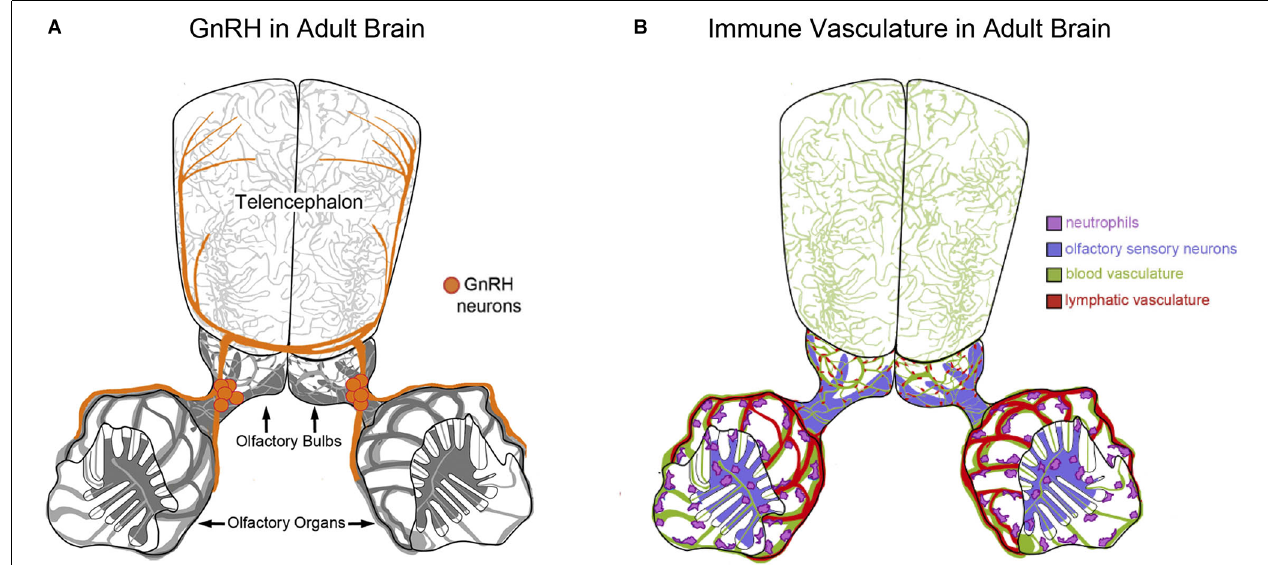
FIGURE 2 | Neuroendocrine and immune factors that potentially modify olfactory function. (A,B) Diagram of the brain of adult zebrafish depicting olfactory organs and telencephalon. (A) Gonadotropin releasing hormone 3 (GnRH3) containing neurons (orange) of the terminal nerve are found intimately associated with the blood/lymphatic vasculature of the olfactory organ. (B) Neutrophils (pink) are associated with the extensive blood/lymphatic vasculature system (green/red) wrapping the olfactory organs as well as OSNs within the olfactory epithelia (purple) in zebrafish (Palominos et al., 2021).